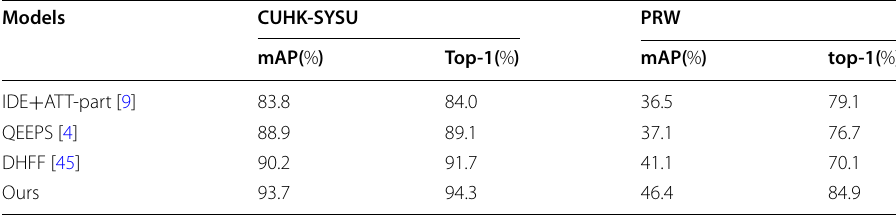
Table 2 Comparison of attention network